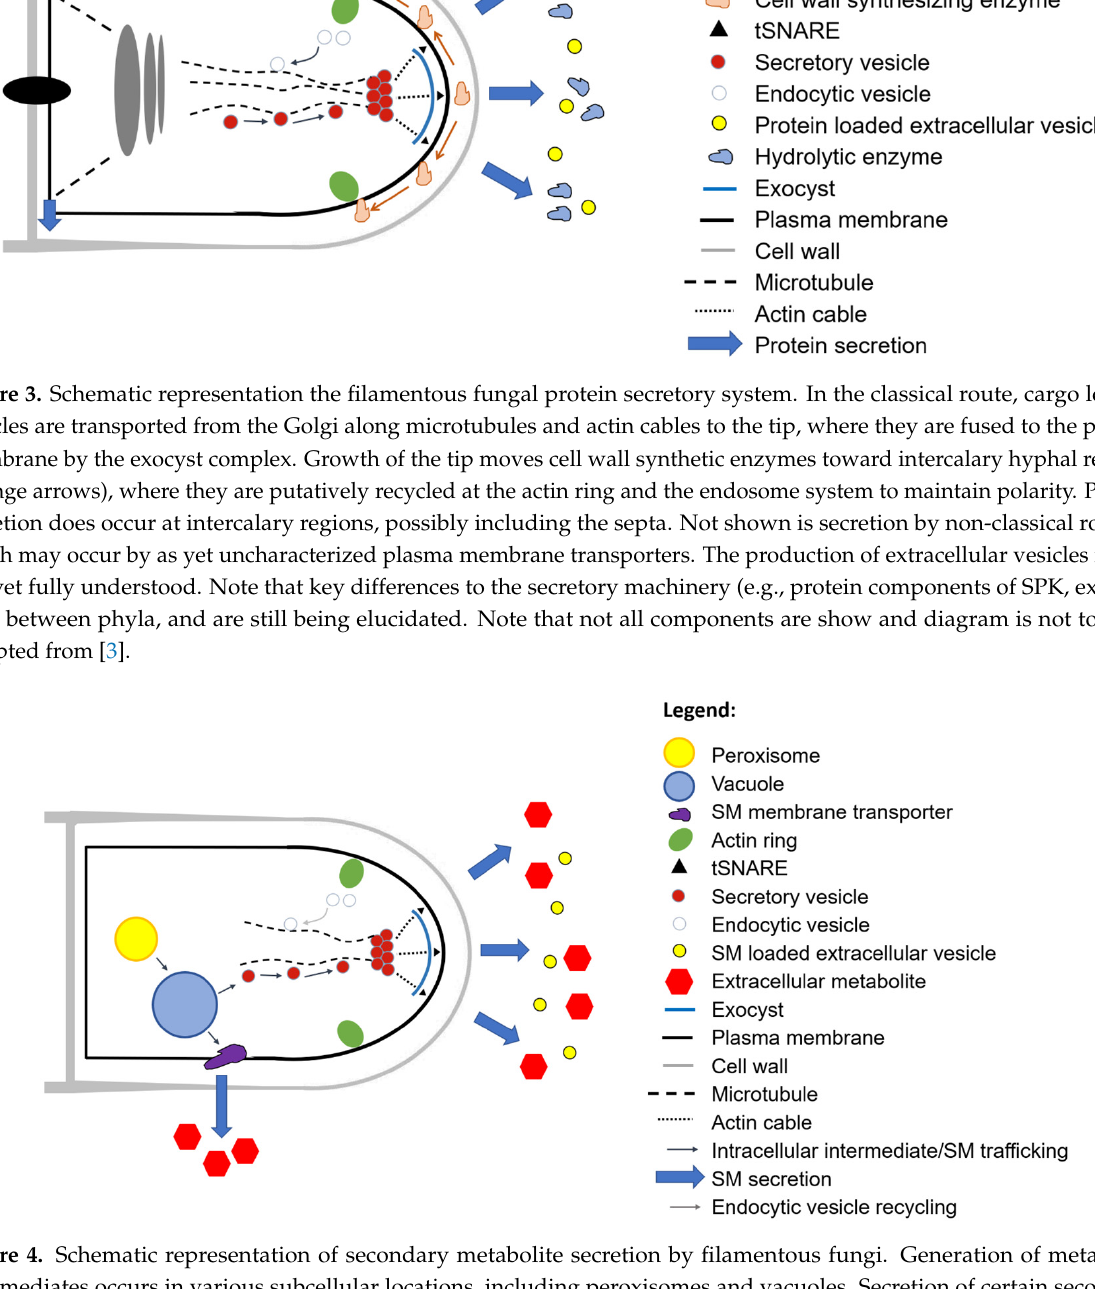
Figure 5. Schematic representation organic acid secretion by filamentous fungi. Many organic acids are intermediates of the Krebs cycle in the mitochondria. Under certain conditions, membrane trans- porters export organic acids firstly into the cytosol and then across the plasma membrane. Several such transporters have now been functionally characterized, but in general their location on the hypha (e.g., tip or intercalary regions) is unknown. Note that not all components are show and dia- gram is not to scale. Adapted from [3]. 2. Polar Growth While spore dispersal can occur across very large distances (including between con- tinents [38]), fungi are in the vast majority of cases non-motile, and consequently filamen- tous species colonize substrates by extension of highly polar cells termed hyphae. The shape of the hypha is dependent on the cell wall, which is a complex, yet spatially orga- nized, mesh of polysaccharides and proteins (recently reviewed in [39]). Abundant sugars in the cell walls of Ascomycota are 1,3- β -glucan, 1,4- β -glucan, 1,6- β -glucan, and chitin, the latter of which is composed of N-acetylglucosamine monomeric units [40]. Additional sugars include galactomannan, galactosamine, glycosaminoglycans, alpha-1,3 glucans,